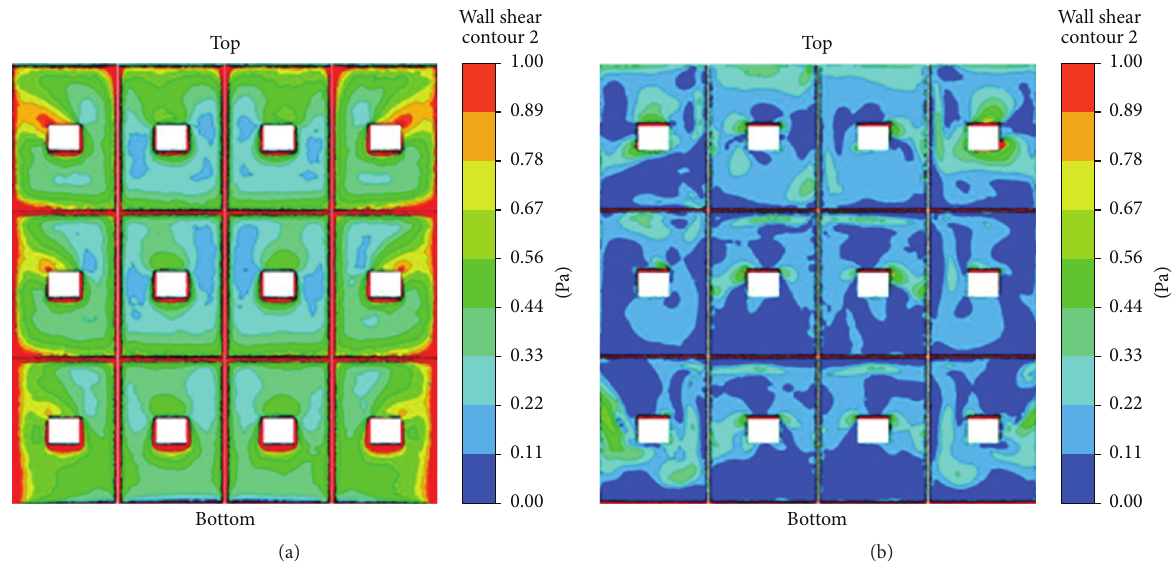
Figure 19: Wall shear stress (N/m 2 ) contours at panels with holes: (a) upwind side and (b) downwind side.